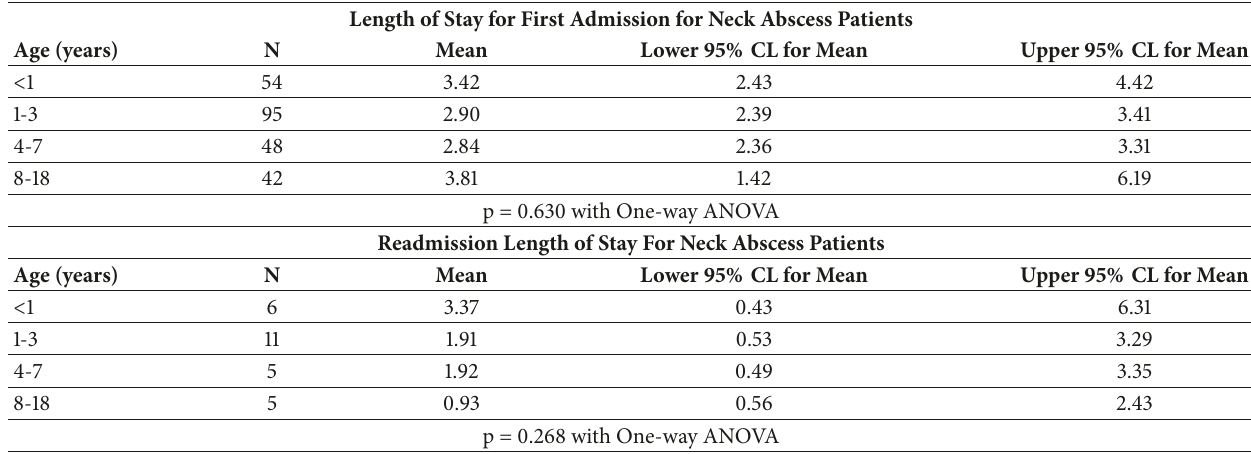
Table 1: Analysis of length of stay (days) among pediatric age groups.